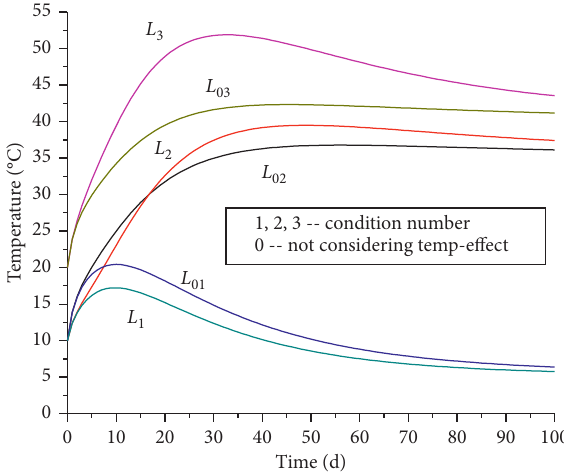
Figure 1: The temperature process curve of point